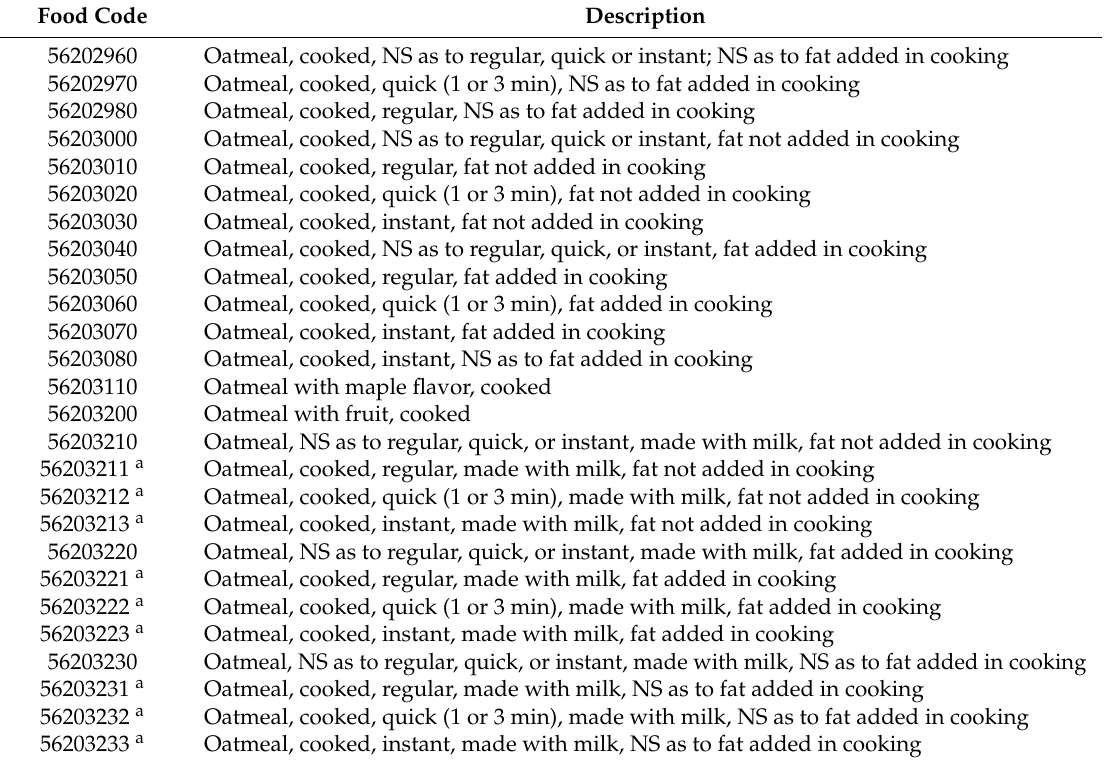
Table 1. Food codes representative of cooked oatmeal within the 2003–2012 NHANES databases. Food